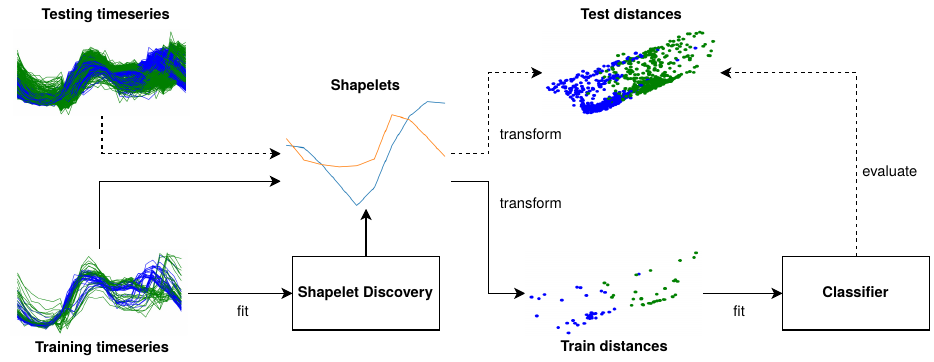
Figure 1. A schematic overview of shapelet